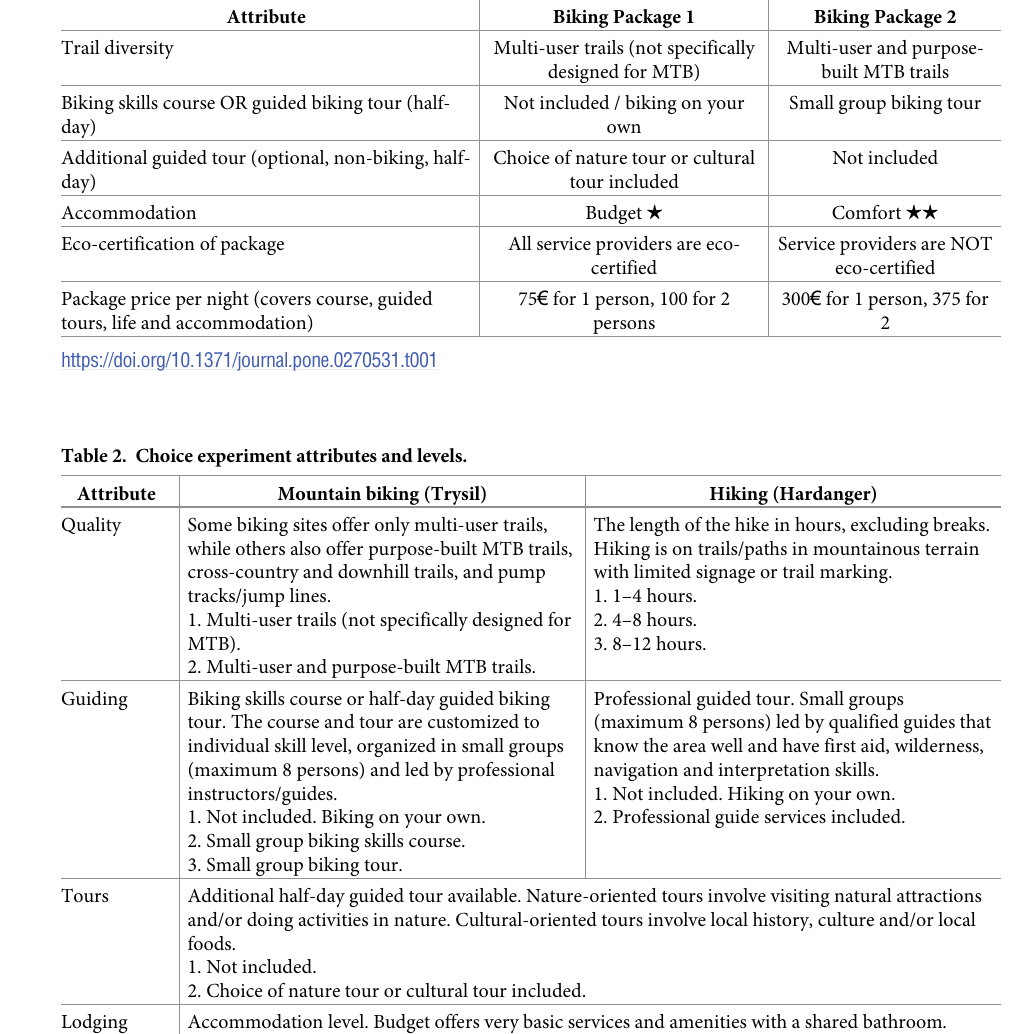
Table 1. Illustrative choice experiment